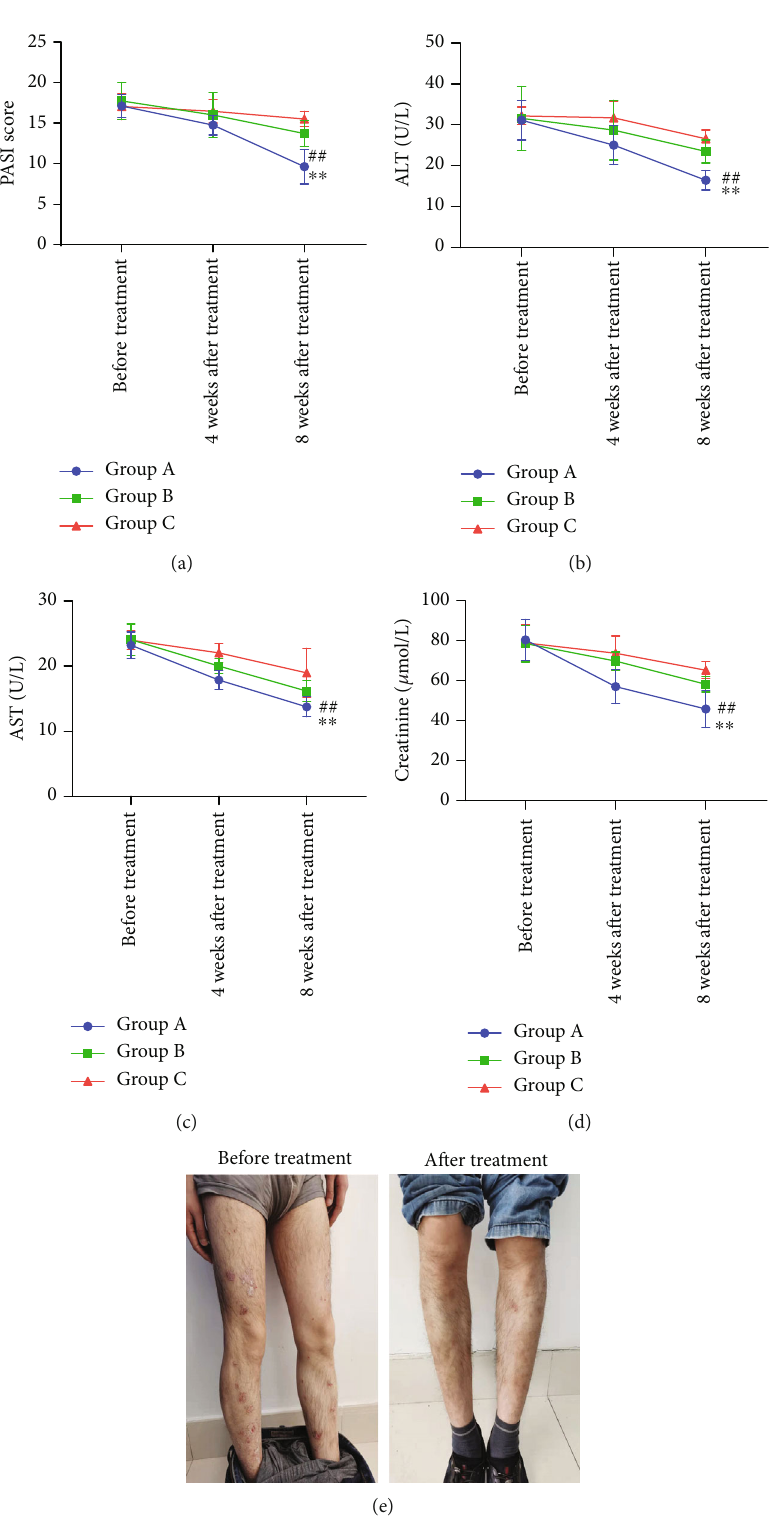
Figure 1: Comparison of treatment e ffi cacy among the three groups. Psoriasis area and severity index (PASI) score (a), serum alanine aminotransferase (ALT) level (b), serum aspartate transaminase (AST) (c), and serum creatinine (d) level were detected in the patients of the group A (blue), group B (green), and group C (red). (e) Representative images showed the area of skin erythema before and after treatment with WTGs+acitretin (group A). ∗∗ p < 0 : 01 vs. group C; ## p < 0 : 01 vs. group B. Group A, TWG tablets + acitretin capsules; Group B, compound glycyrrhizin capsules + acitretin capsules; Group C, acitretin capsules